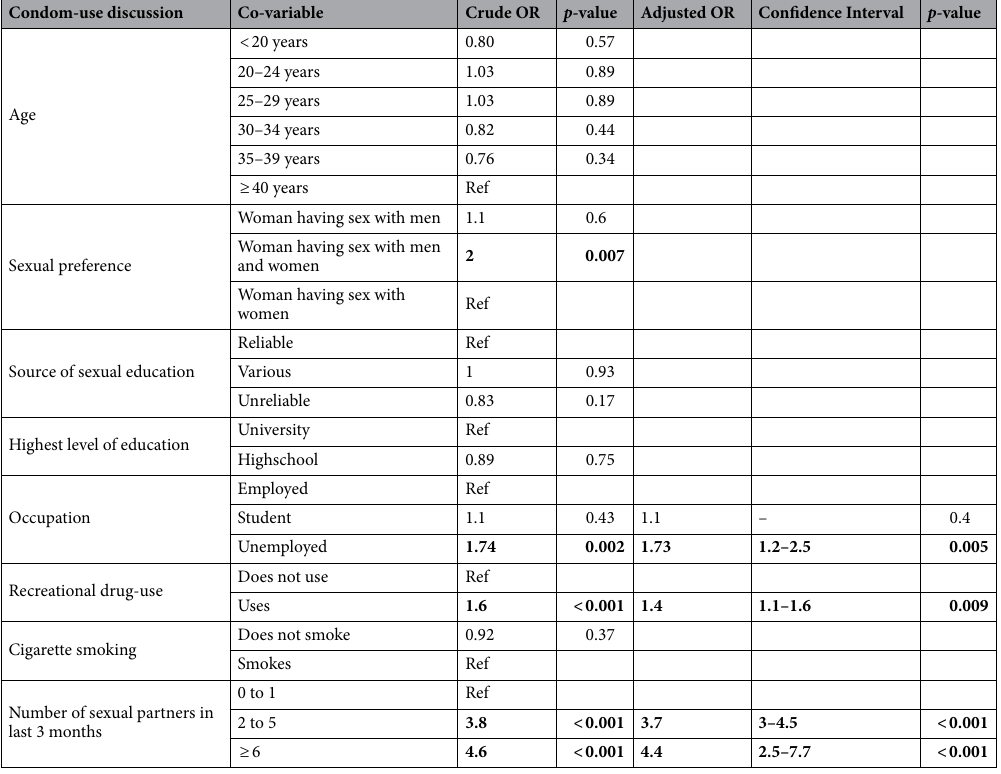
Table 4. Binomial regression model for condom-use discussion with one-time partners with crude and adjusted odds ratios (ORs). Significant results are in